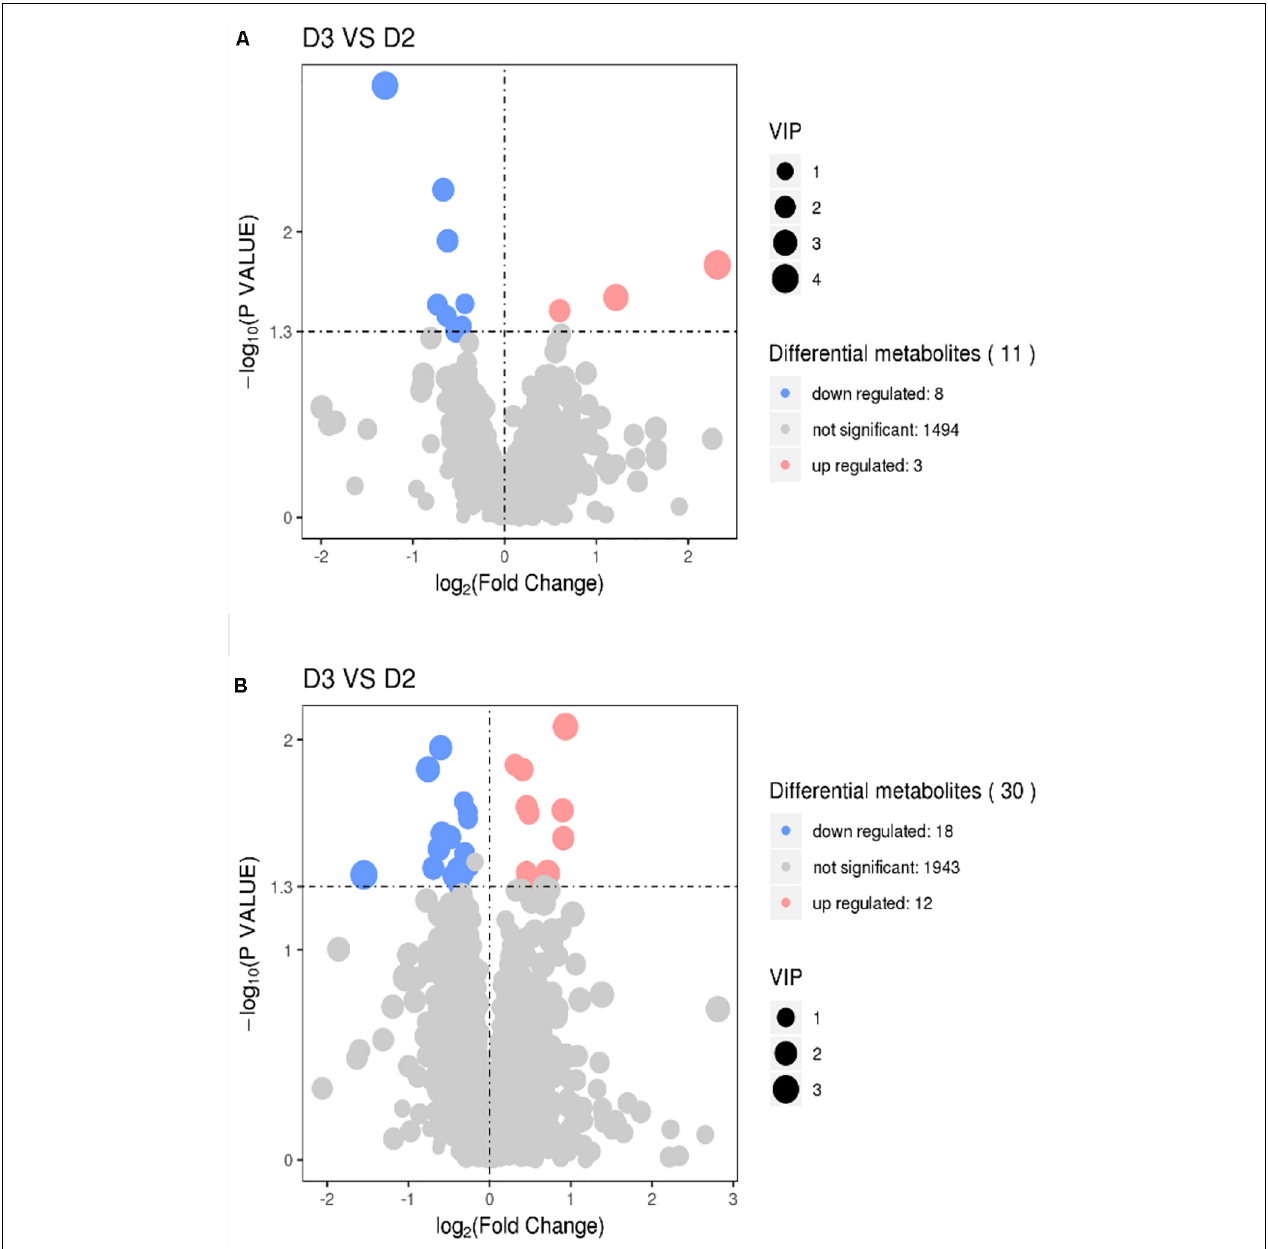
FIGURE 4 | Volcano plots for the potential differential metabolites in the liver of American eels of the OPC group in comparison with the HIS group under positive ion mode (A) and negative ion mode (B) . The point size represents the VIP value of the PLS-DA. Pink points indicate significantly upregulated metabolites, and blue points indicate significantly downregulated metabolites. D 2 = HIS group, D 3 = OPC